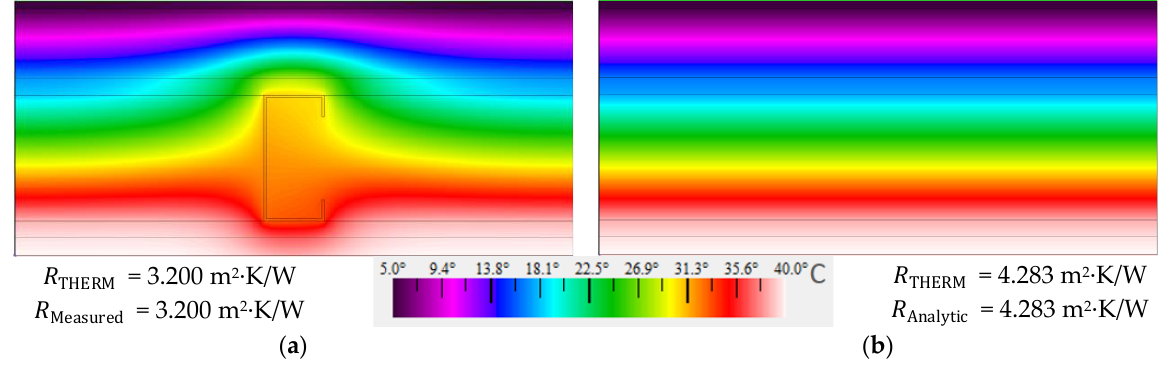
Figure 7. Accuracy verification of the THERM models: temperature distribution and conductive R - values. ( a ) Inhomogeneous layers. ( b ) Homogeneous